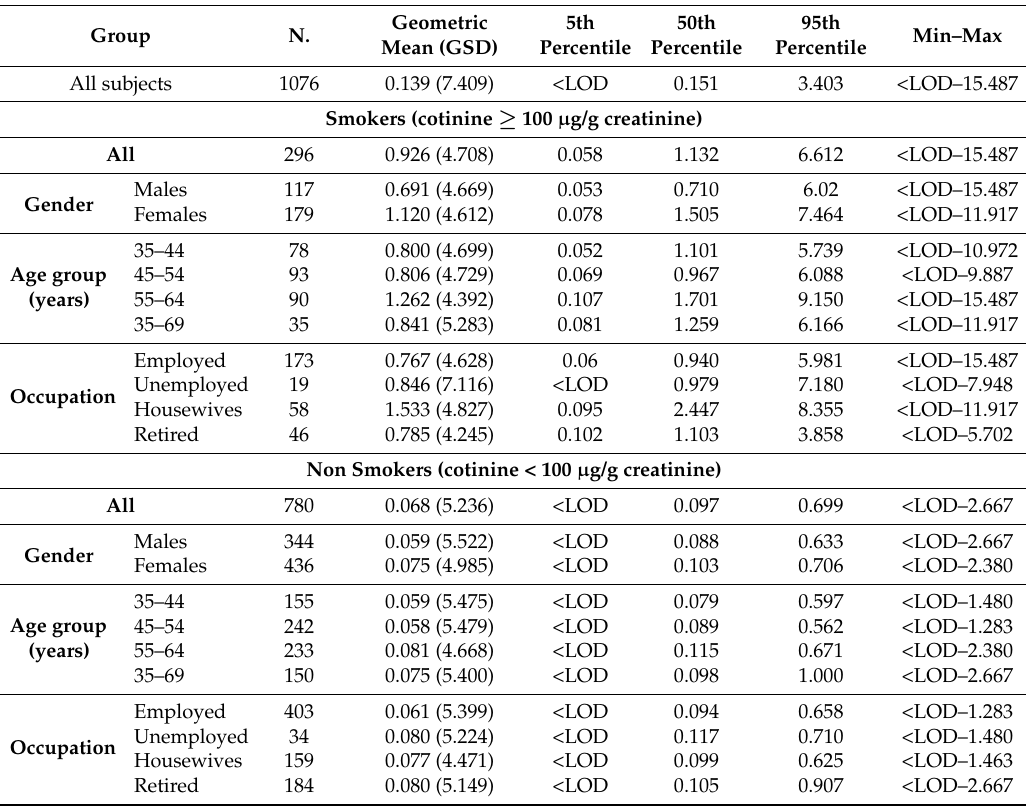
Table 2. Urinary S-phenyl-mercapturic acid (SPMA) concentrations ( µ g/g creatinine).